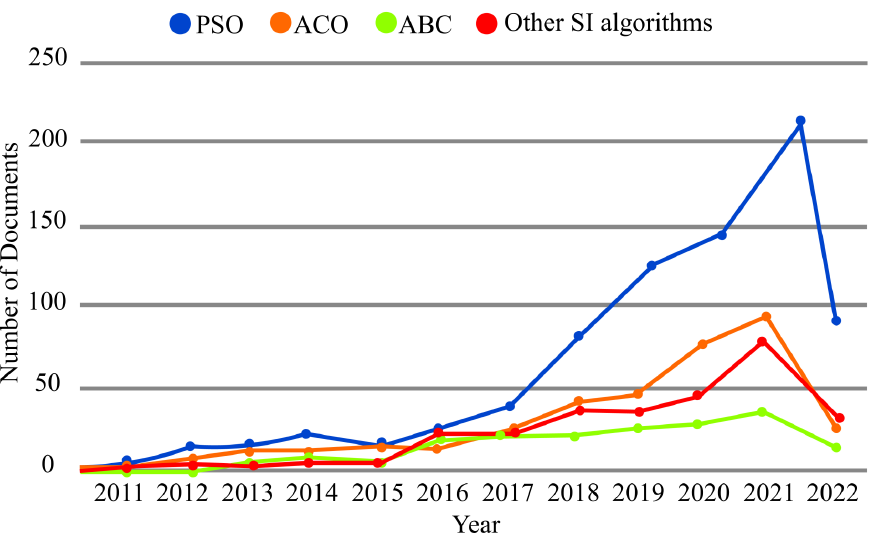
Figure 7. Statistics of PSO, ACO, ABC, and other SI algorithms in the field of